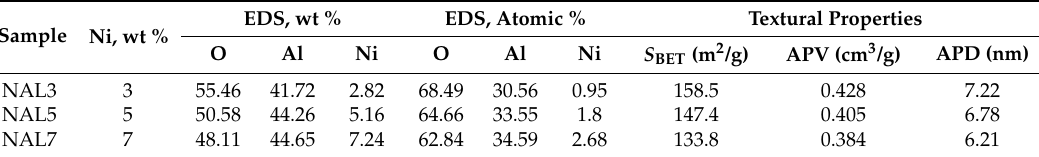
Table 1. Chemical composition and textural parameters of Ni/ γ -Al 2 O 3